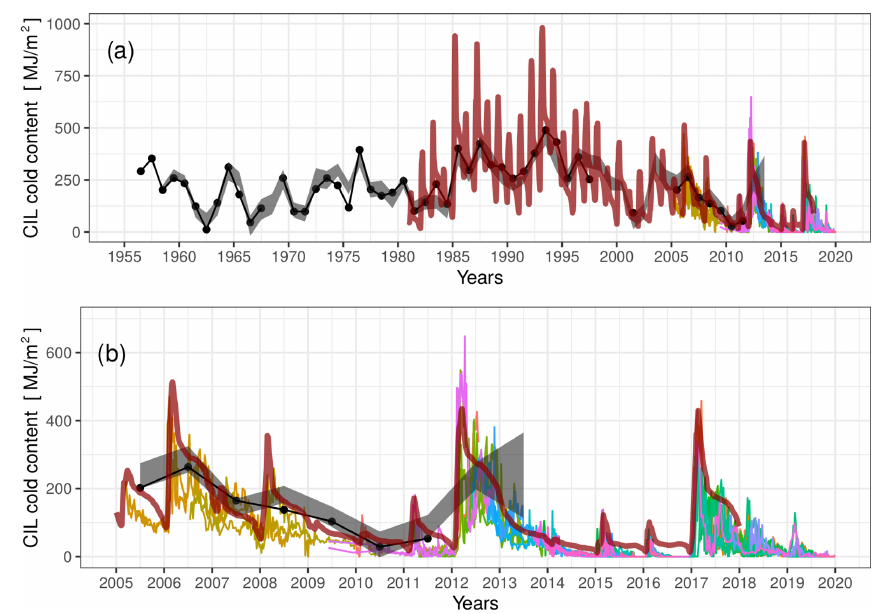
Figure 1. Time series of the Black Sea CIL cold content ( C ) originating from various data sources (Table 1), displayed at original temporal resolution: (black dots) inter-annual trend derived from ship casts; (gray-shaded area) confidence bounds ( p < 0 . 01) of the statistical model based on winter air temperature anomalies; (thick dark red line) GHER3D model; (thin colored lines) individual Argo floats. (a) Complete period of analysis, (b) focus on recent